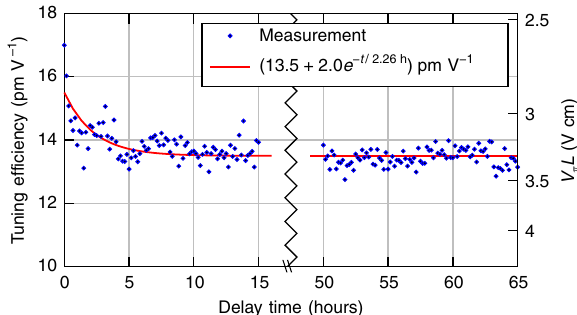
Fig. 2 Poling stability of the electro-optic fi lm. Tuning ef fi ciency (C-band ring) as a function of time after poling. The axis on the right shows the estimated corresponding V π L